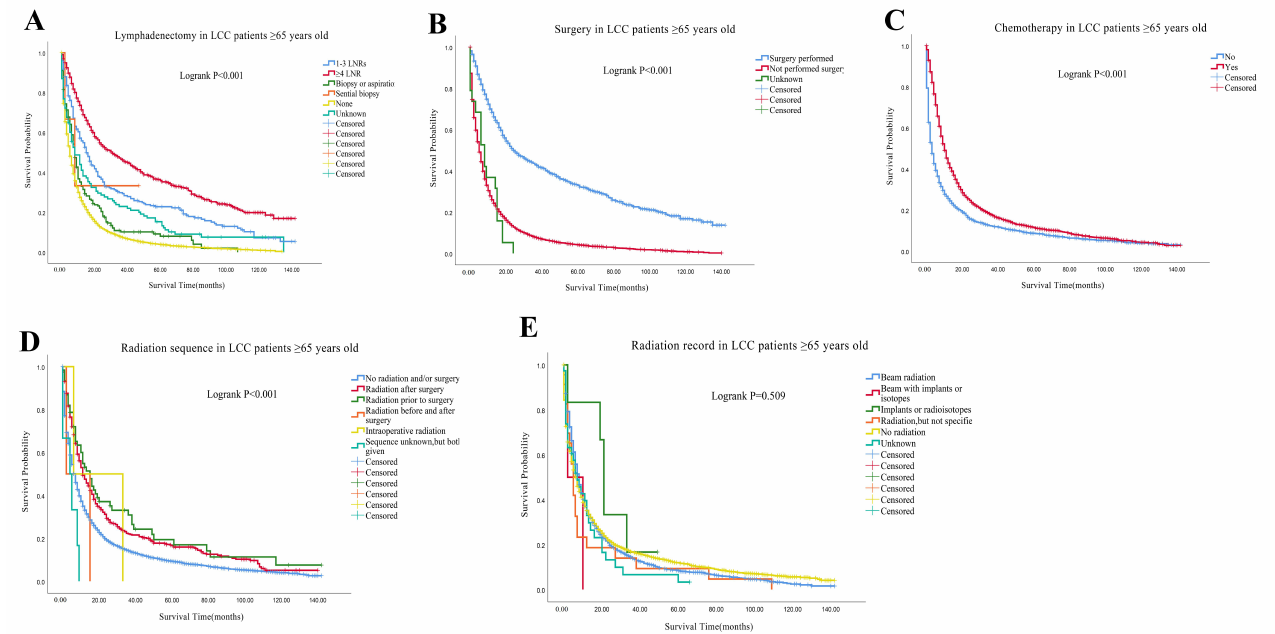
Figure 4. Comparison of survival curves of OS in different therapeutic subgroups of LCC patients ≥ 65 years old. ( A ) Comparison of lymphadenectomy subgroup; ( B ) Comparison of surgery sub- group; ( C ) Comparison of chemotherapy subgroup; ( D ) Comparison of radiation sequence subgroup; ( E ): Comparison of radiation record subgroup. Abbreviations: LCC: large cell carcinoma; LNRs: lymph nodes removed; OS: overall